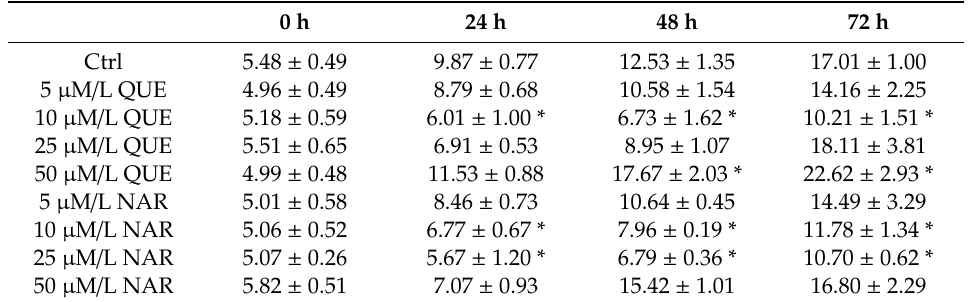
Table 4. Boar sperm DNA fragmentation (%) following exposure to quercetin or naringenin ( n =